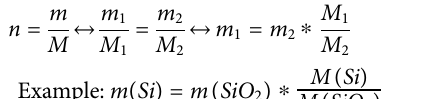
Ostracods and other microscopic remains larger than 125 µm were analyzed in 47 samples (12 from Area A, UA1 – UA4; 35 from Area B, UB1 – UB10; Figure 3 ). 500 g of dry sediment was treated with 10% H 2 O 2 until reaction stopped (3 – 24 h). The residues were washed through a 2 mm and 125 µm sieve using distilled water and dried at 50 ° C. All microfossils (ostracods, gastropods and opercula, charophyte gyrogonites, thecamoebians, fi sh bones/teeth) were extracted under OPTIKA stereoscopes. Ostracods were further photographed using a JEOL 6300 Scanning Electron Microscope ( Figure 4 ). Identi fi cation, ecology and distribution information of ostracod species were derived mainly from Danatsas (1994), Meisch (2000), Frenzel et al. (2010), Fuhrmann (2012), Mazzini et al. (2014) and several papers of the Stereo Atlas of Ostracod Shells (Athersuch et al., 1973-1996). The number of species is an indicator of the stability of the system. Taphonomic indices for the dominant species were calculated and interpreted after Schellenberg (2007) ( Table 5 ) with: a) The adult to juvenile ratio (A/J) as an indirect indication for the energy of the environment. Values between 0.125 and 0.25 are typical for in situ death assemblages. Higher values re fl ect in situ death assemblages with taphonomic removal of juveniles. Signi fi cantly lower values could re fl ect transported juvenile valves or a mass death event (Belis, 1997; Schellenberg, 2007). b) The right valve/left valve ratio (RV/LV) is also considered as an indirect proxy for the energy of the depositional environment (Breman, 1980). c) The percent articulation ratio (%Art.) is an indicator of a disturbed sediment – water interface when values are lower than the common range value of most samples (Frenzel and Boomer, 2005; Hussain et al., 2007). For certain samples and species no taphonomic indices were applied, as the total number of valves per sample was too low.